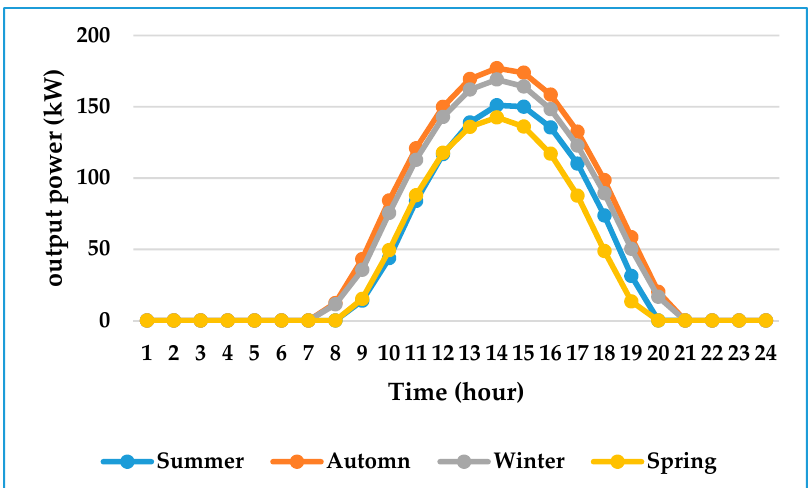
Energies 2017 , 10 , 811